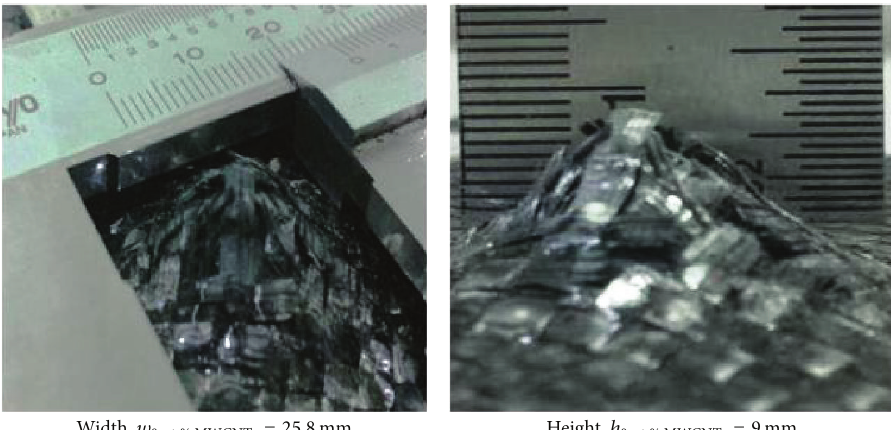
Width, w 0wt.%MWCNTs = 25.8 mm Figure 7: Pyramidal damage of asymmetric CFRP with 0 wt.% MWCNTs mixed in epoxy.